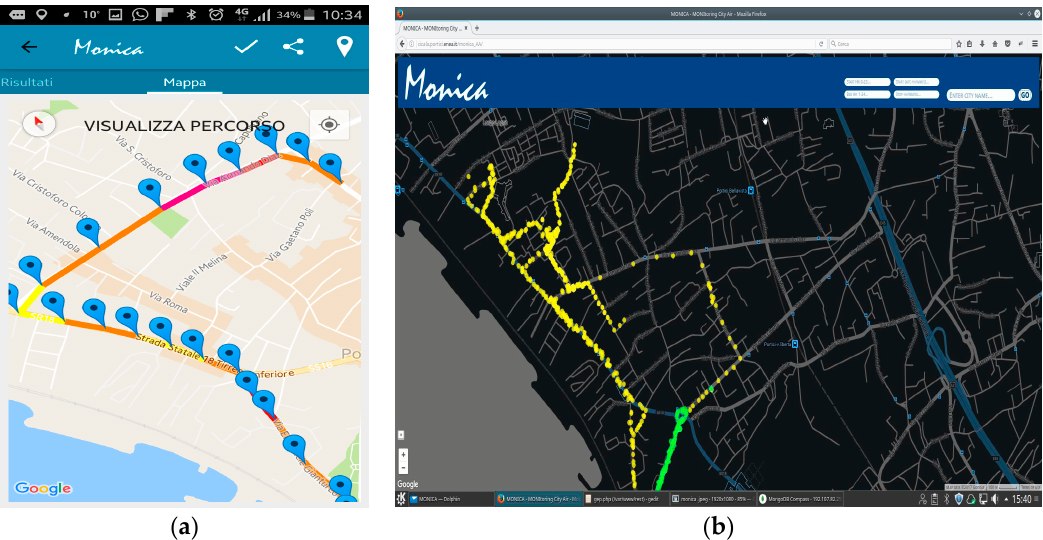
Figure 2. ( a ) Android App activity showing the colour coded route during a mobility session and ( b ) an example of the web based pollution map built with simulated